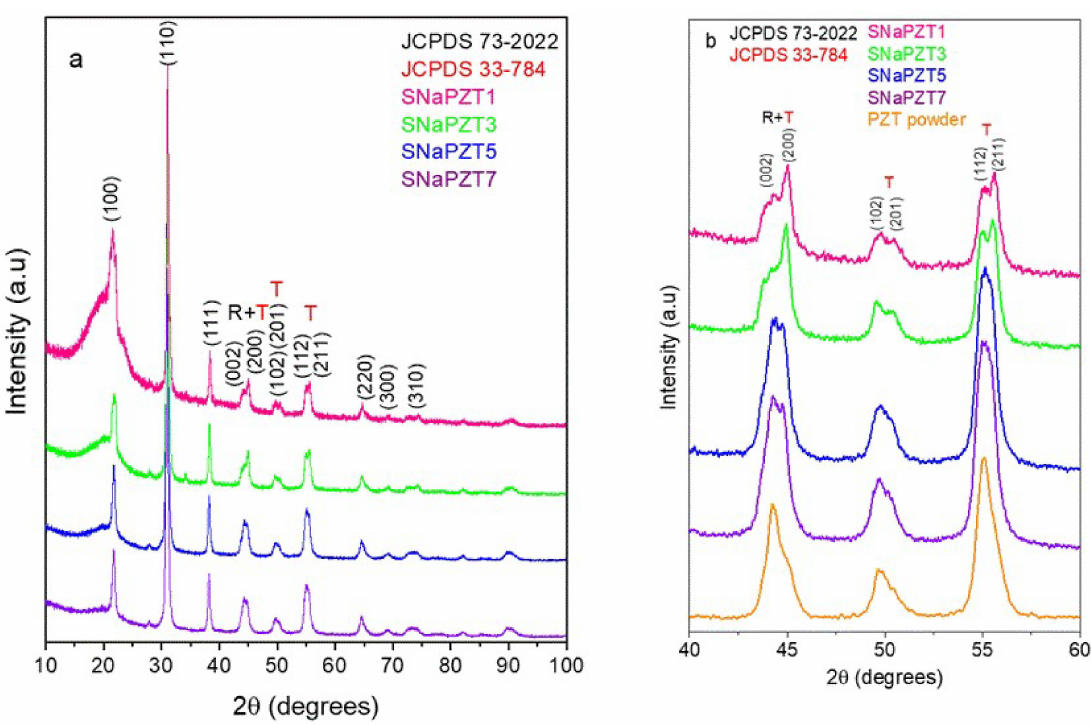
Figure 10. XRD pattern of ( a ) flexible composite films and ( b ) comparison between PZT powder and flexible composite films in the region of 2 θ between 40 ◦ and 60 ◦ .